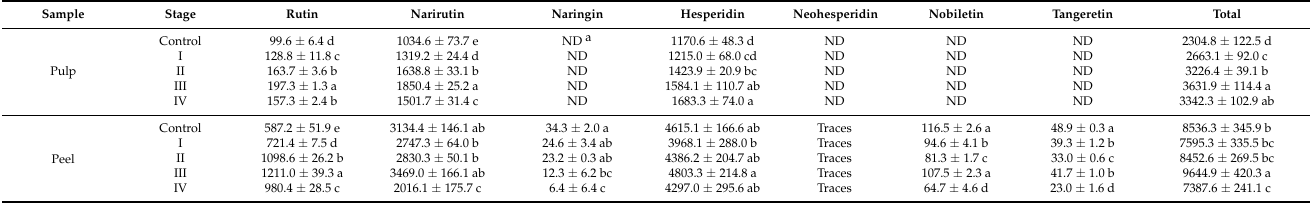
Table 1. Flavonoid contents (mg/100 g 70% ethanol dry extract) according to the degree of sunburn in Satsuma mandarin